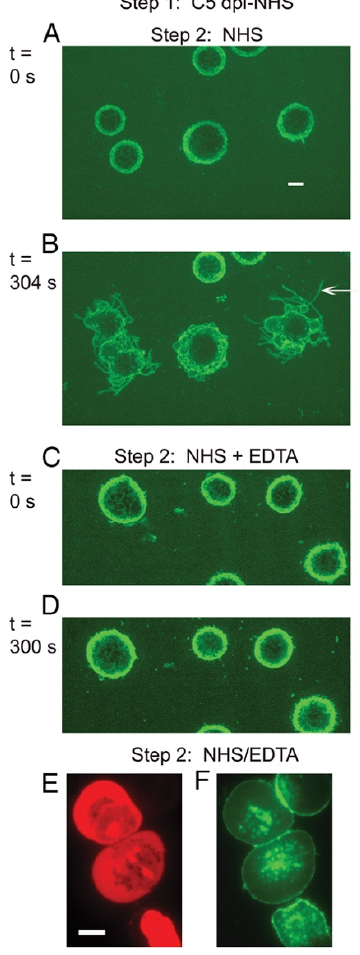
Figure 7. Production of streamers requires Ca 2+ . OFA-opsonized cells reacted with C5-depleted NHS do not exhibit streaming when they are incubated with NHS + EDTA. ( A – D ) Al488 mAb 3E7 was used to visualize the C3b-opsonized cells, and representative images from spinning disc confocal microscopy (SDCM) movies are displayed at time 0 ( A ) and ( C ) and after 304 or 300 s ( B ) and ( D ). A streamer in ( B ) is identified by the arrow. Images shown are representative of more than 20 similar experiments. Magnification at 63× in all images. Scale bar = 5 microns. ( E ) and ( F ) Fluorescence microscopy (FM) analysis of Al488 OFA-opsonized Daudi cells subjected to the two-step protocol and then stained with PI to identify dead (stained red) cells. Although the cells are dead ( E ) there is no evidence for blebbing or steamers. Magnification at 100×; scale bar = 10 microns. Representative of more than 15 fields examined in